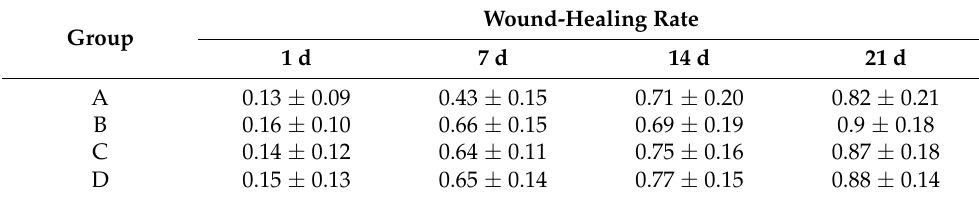
Table 1. Wound-healing rate at each time point of scald (x ± s).